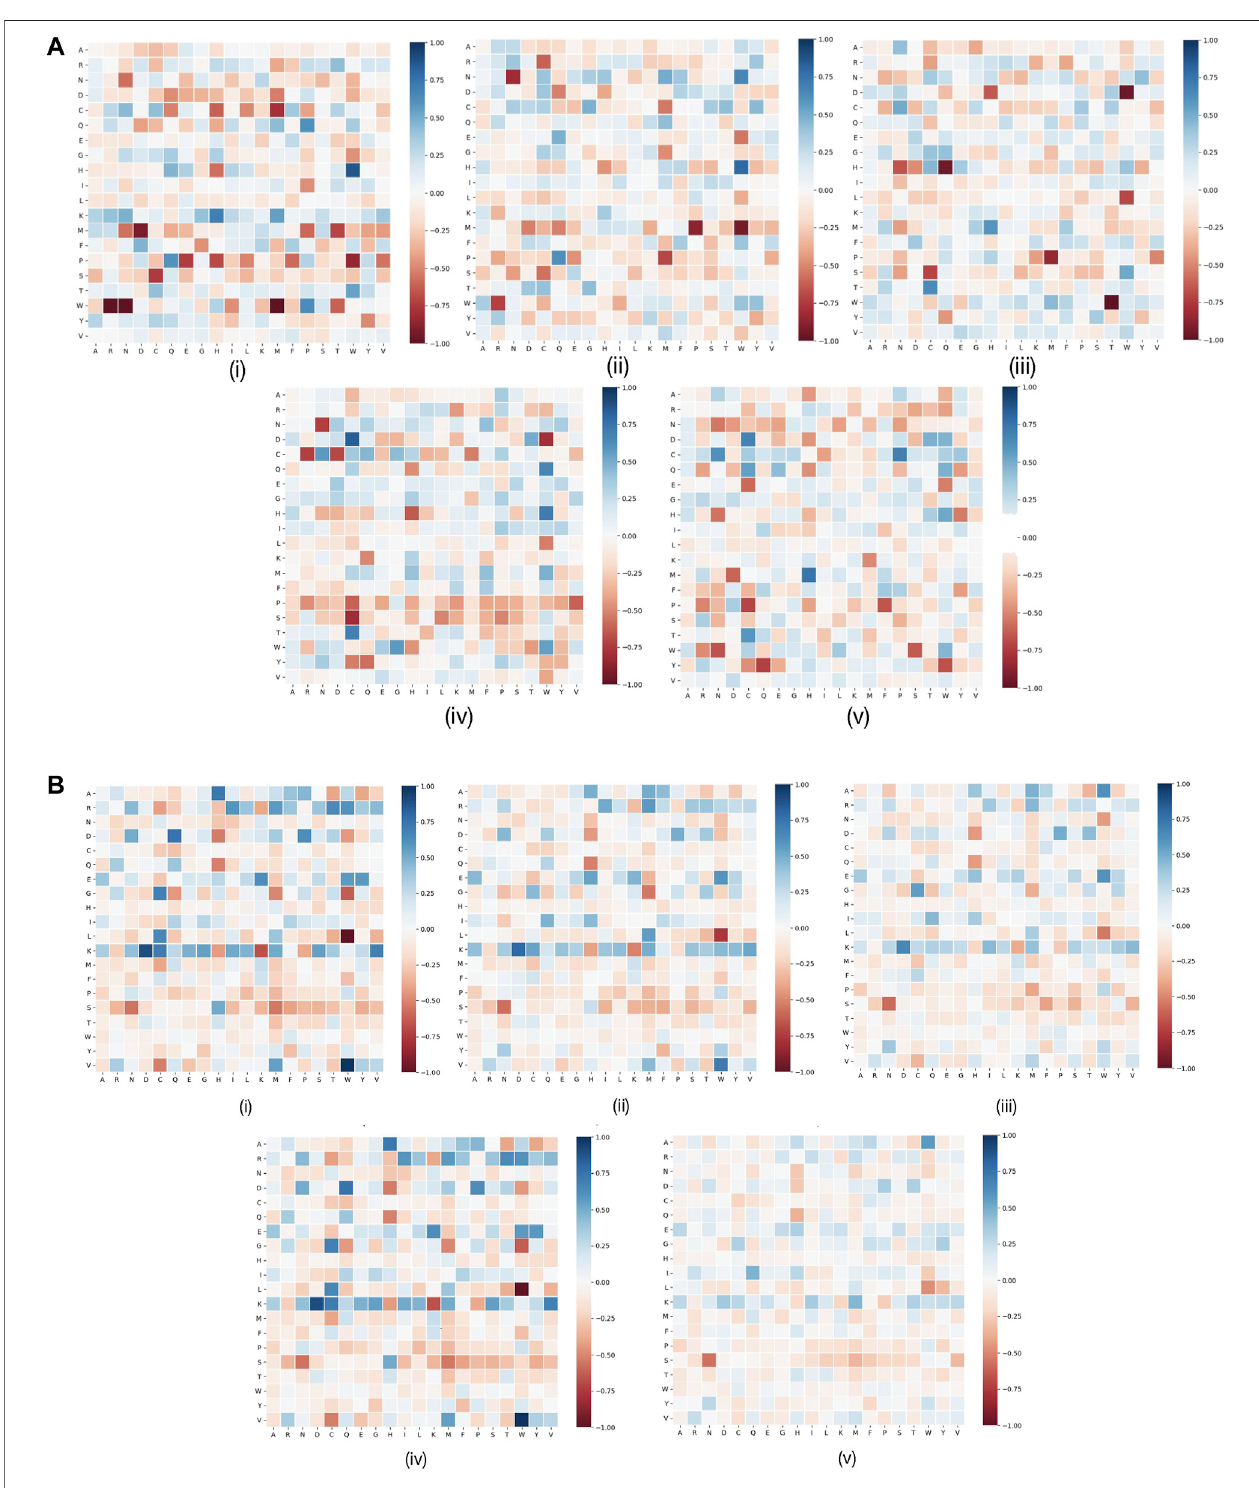
FIGURE 3 | Visualization of features RRPC and AAPC. In detail, for Figure (A) , (i) RRPC of a window size of 10, (ii) RRPC of a window size of 15, (iii) RRPC of a windowsizeof20,(iv)RRPCofawindowsizeof25,and(v)RRPCofawindowsizeof30.ForFigure (B) ,(i)AAPCofawindowsizeof10,(ii)AAPCofawindowsizeof15, (iii) AAPC of a window size of 20, (iv) AAPC of a window size of 25, and (v) AAPC of a window size of 30.